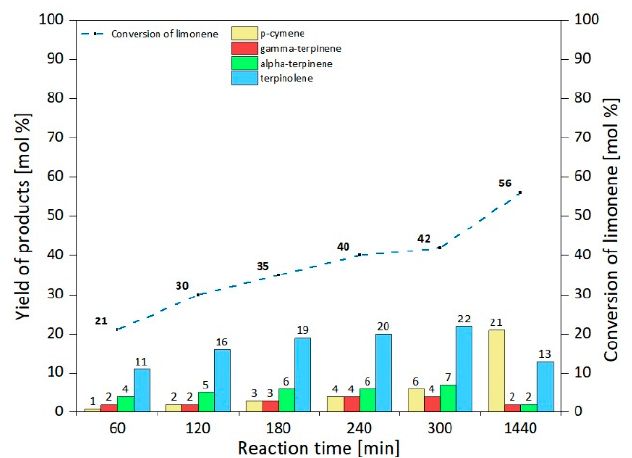
Figure 10. Influence of reaction time on the yield of products of the isomerization of limonene. Amount of the catalyst 0.75 g (15 wt% in relation to mass of limonene). The reaction was performed at 150 °C. (The experimental error was 1 mol%.)